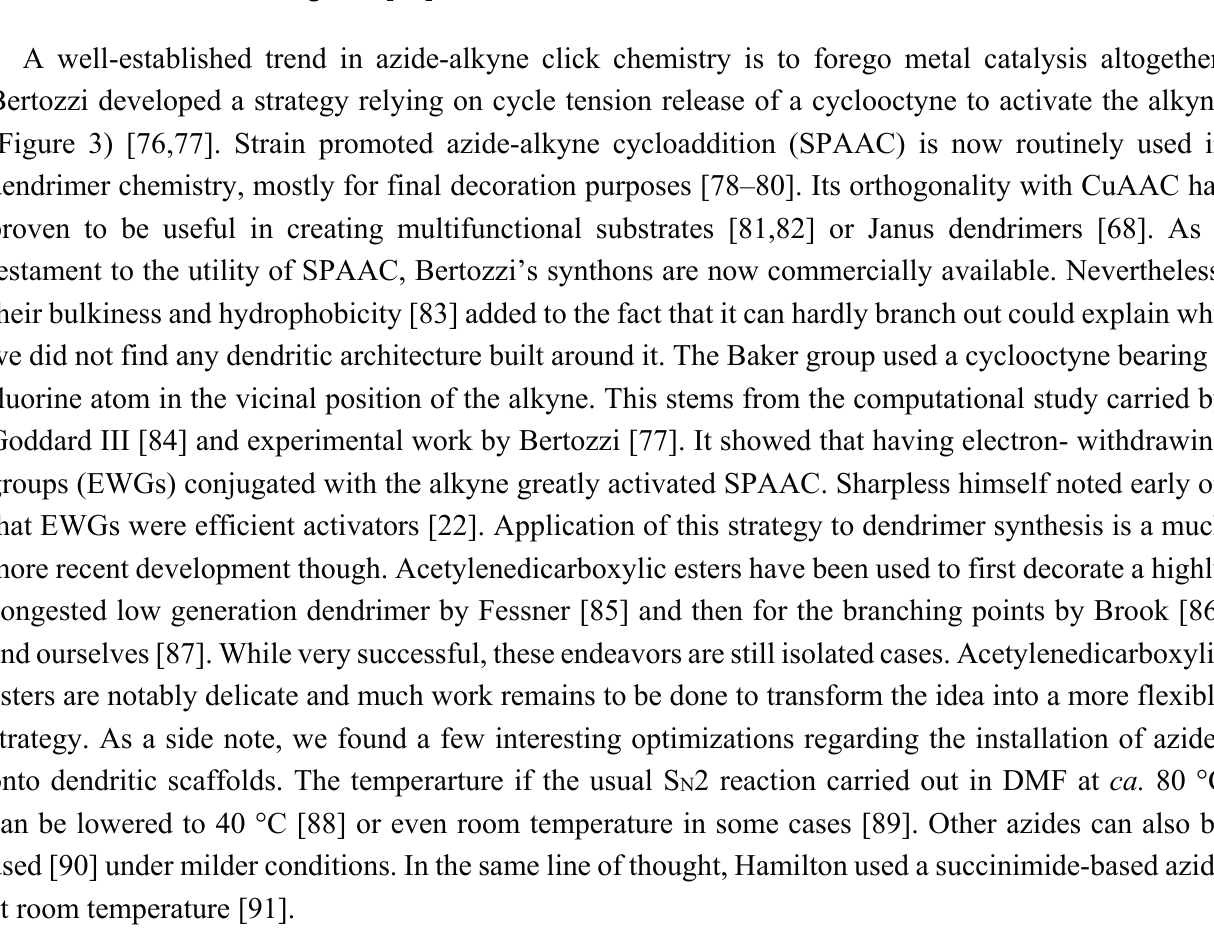
Figure 2. Tris(3-hydroxypropyltriazolylmethyl)amine (THPTA) (left) and tris-(benzyltriazolylmethyl)amine (TBTA) (right). Similar ones have been developed and studied as CuAAC ligands [25].